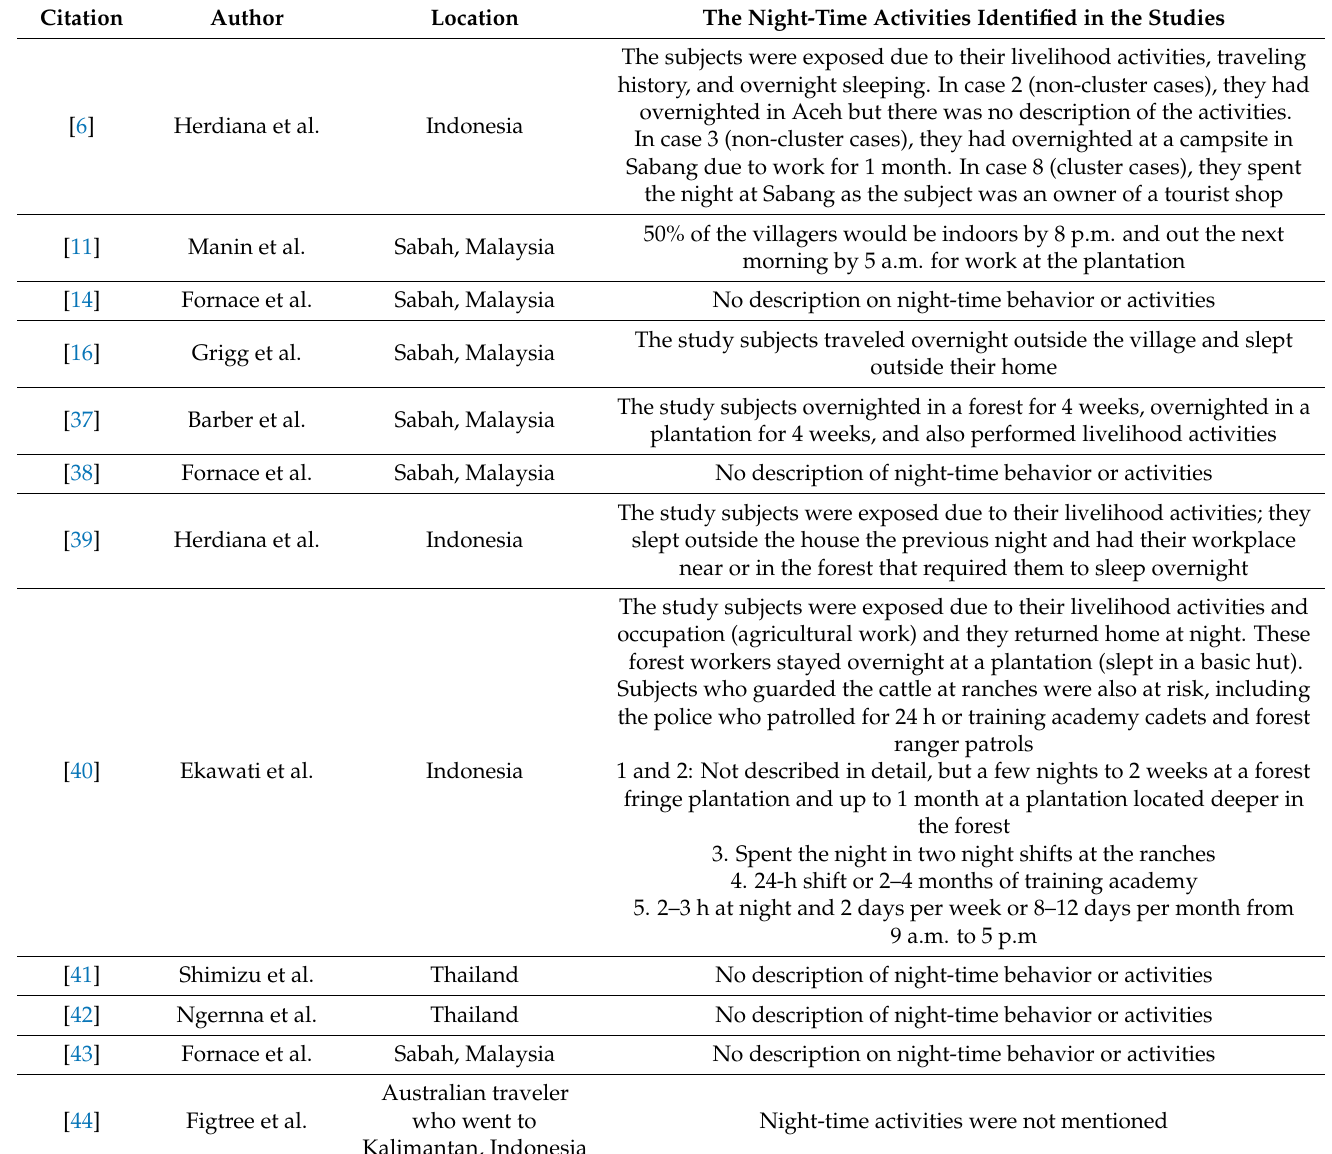
Table 2. Studies including description of human activities at